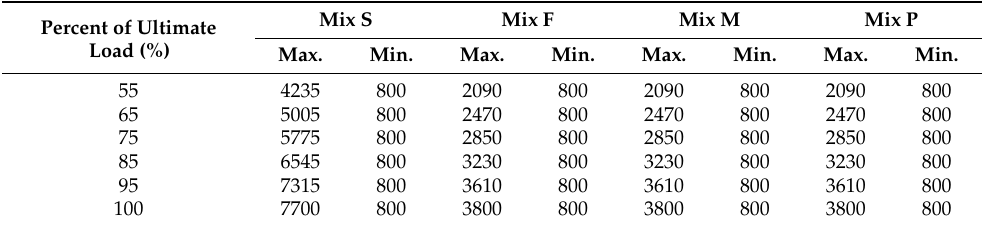
Table 3. Loading force groups for different